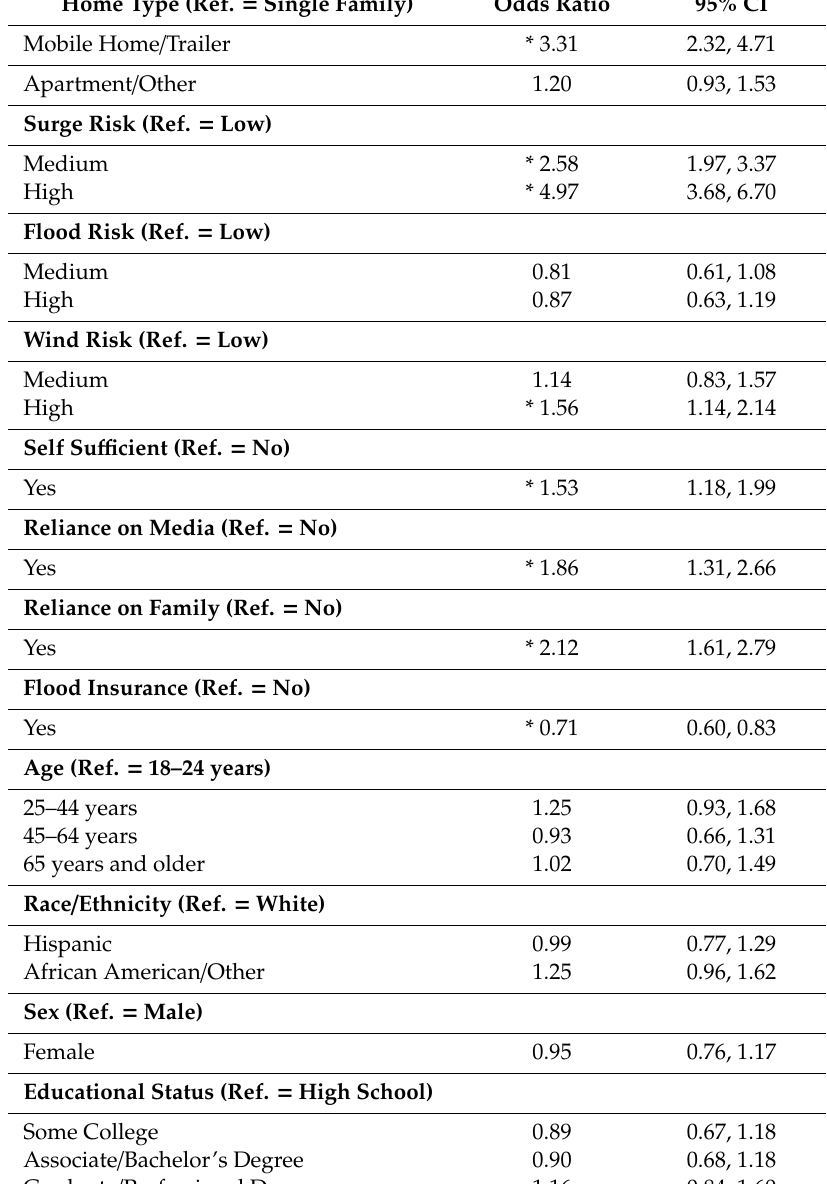
Table 3. Predictors of Hurricane Evacuation in the U.S. Gulf